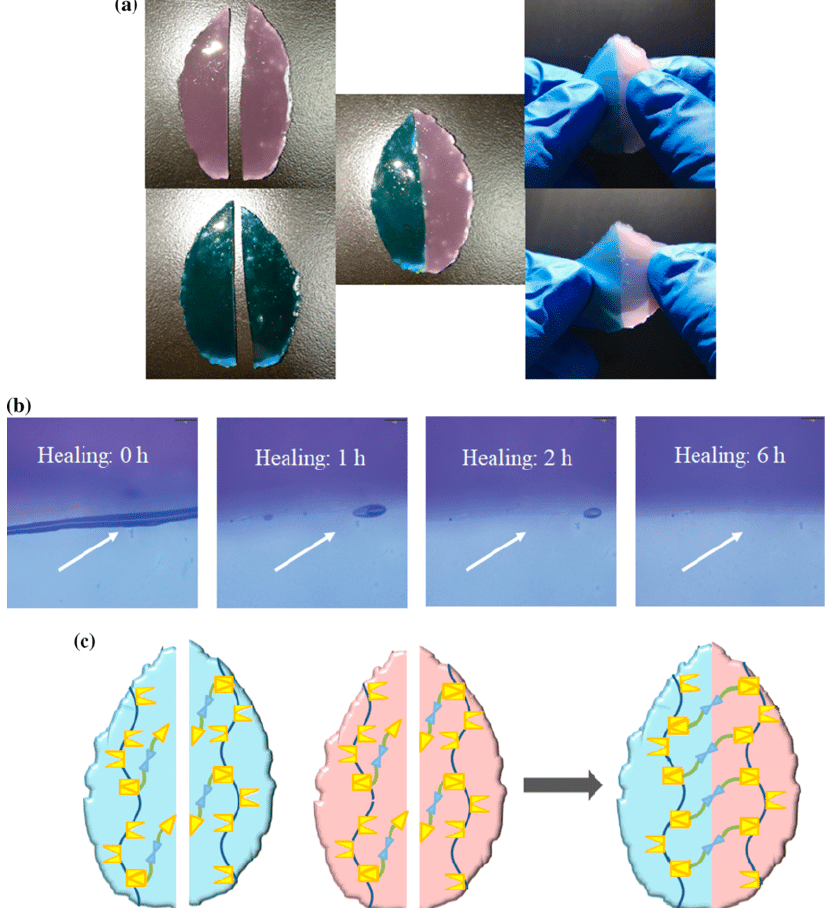
Figure 1. Self-Healing Hydrogels. ( a ) Macroscopic and ( b ) microscopic images of DCMC-based hydrogels (8%) pre and post self-healing, ( c ) Schematic image of the dynamic hydrogel networks through self-healing